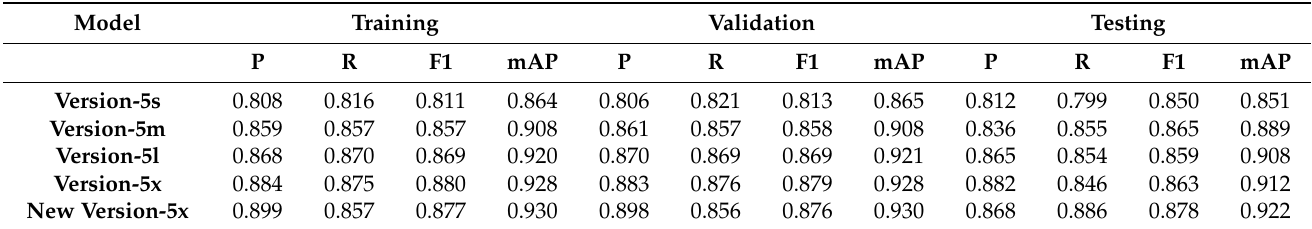
Table 3. Performance comparison of all fi ve models used in the experimental study using statistical indicators.